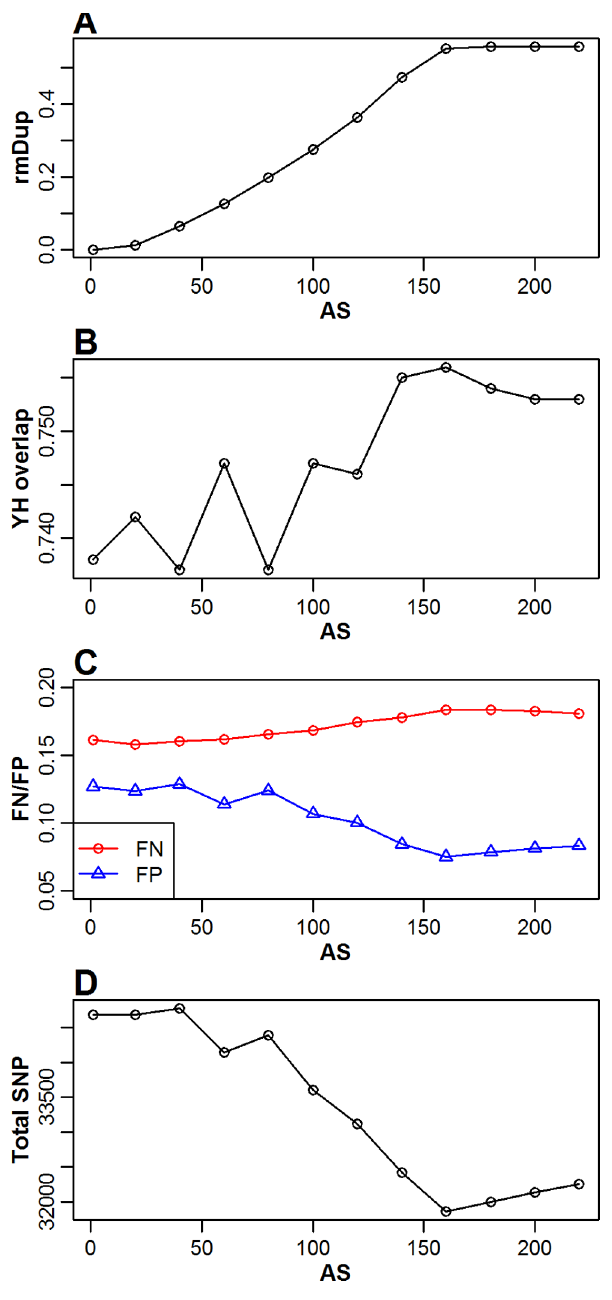
Figure 3. The relationship between the Alignment Score (AS) and duplication, YH-WGS overlap ratio, FN/FP ratio and total SNP number. (A) The duplication rate increases as the AS threshold increases, eventually reaching a stable level. (B) The percent of SNP overlaps with the YH-WGS. (C) The false negative rate and the false positive rate change with the AS threshold. (D) The total SNP number changes with the AS threshold.